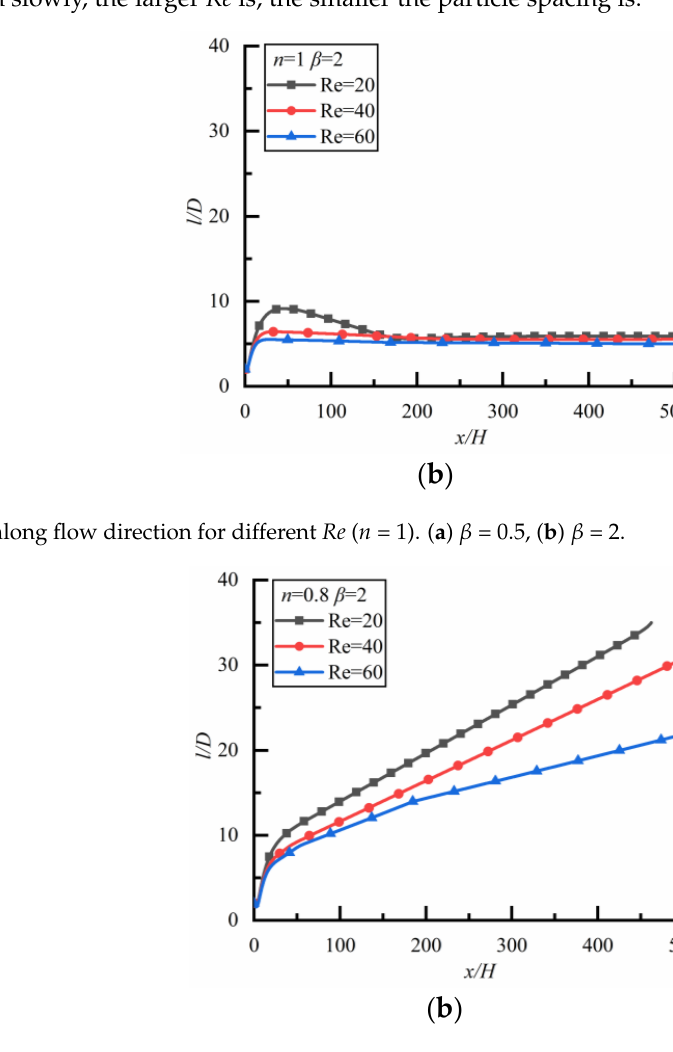
Figure 10. Changes of l/D along flow direction for different Re ( n =0.8). ( a ) β =0.5, ( b ) β =2.